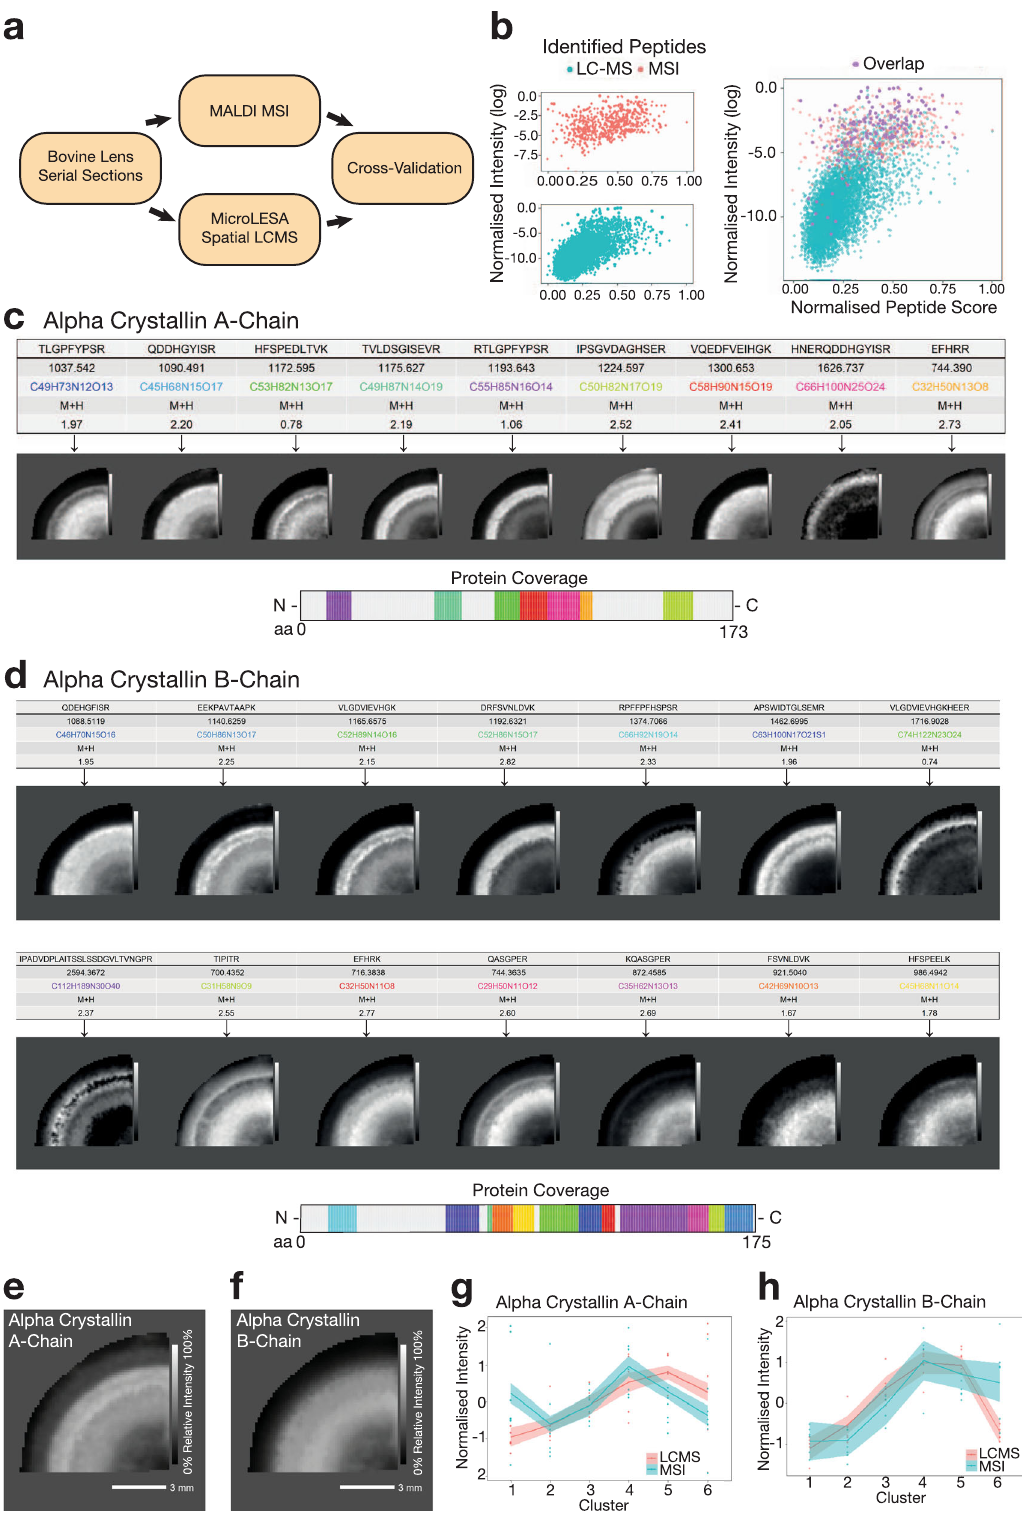
fed into the HIT-MAP annotation pipeline. Initial HIT-MAP segmentation analysis showed an increase in both peptide and protein identi fi cation number as segment number increased (Fig. 7a [left and centre]) similar to that observed in the bovine lens dataset, with stabilisation of protein annotation at 9 segments (Fig. 7a